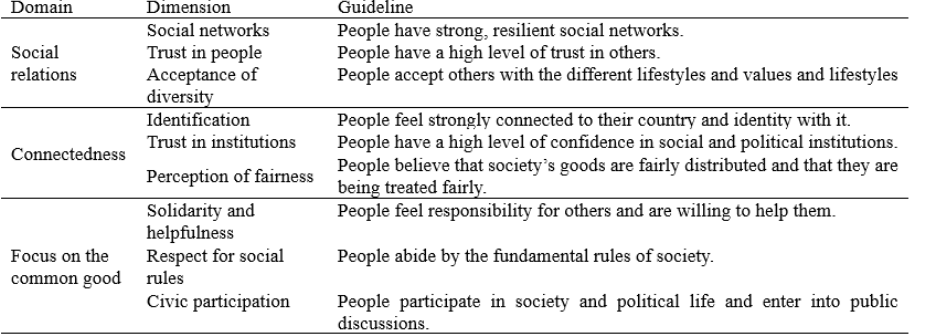
Table 1. The dimensions of social cohesion and their guiding principles (Dragolov et al.,